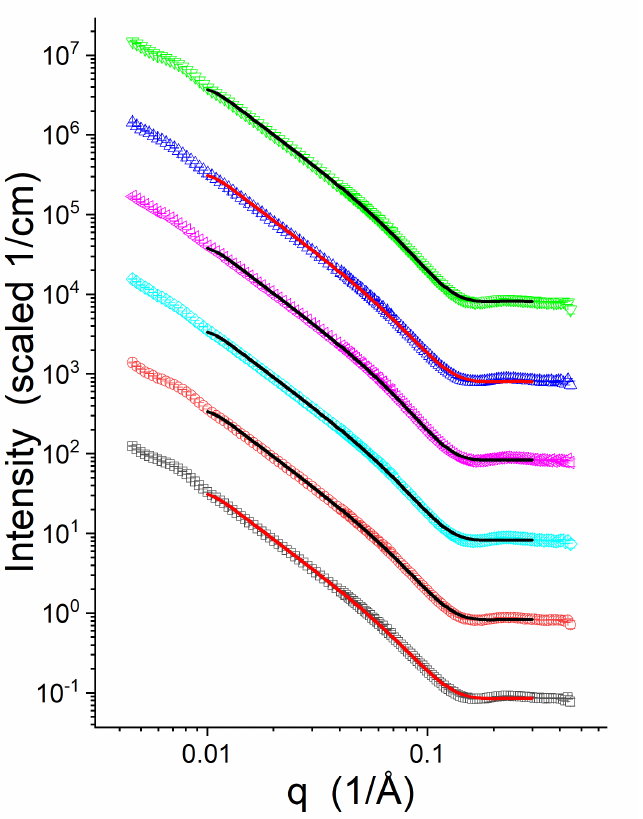
Figure 2. SANS data collected for the vesicles with and without gp41rk. The curves are Lipid-1 P/L = 0 ( (cid:3) ), Lipid-1 P/L = 1/50 ( (cid:13) ), Lipid-2 P/L = 0 ( ♦ ), Lipid-2 P/L = 1/50 ( (cid:67) ), Lipid-3 P/L = 0 ( (cid:52) ), and Lipid-3 ( (cid:79) ). Example model intensity profiles found during the SANS data analysis are shown plotted as solid lines with the various data sets in colors that contrast sufficiently with the data. The data have been offset from Lipid-1 at P/L = 0 data for clarity. Table 2. Results of the SANS data modeling highlighting the important structural